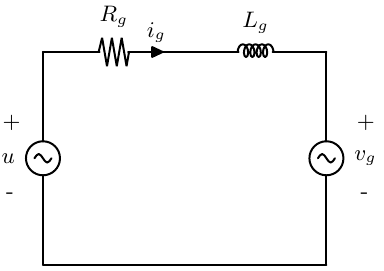
Figure 6. Single-phase equivalent circuit of the grid-connected